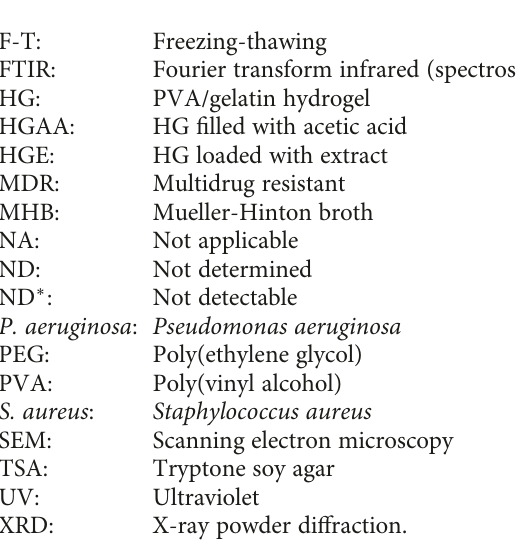
Figure S1: fl ow chart of the methodology used for the prepa- ration of hydrogels. Figure S2: preparation of hydrogels